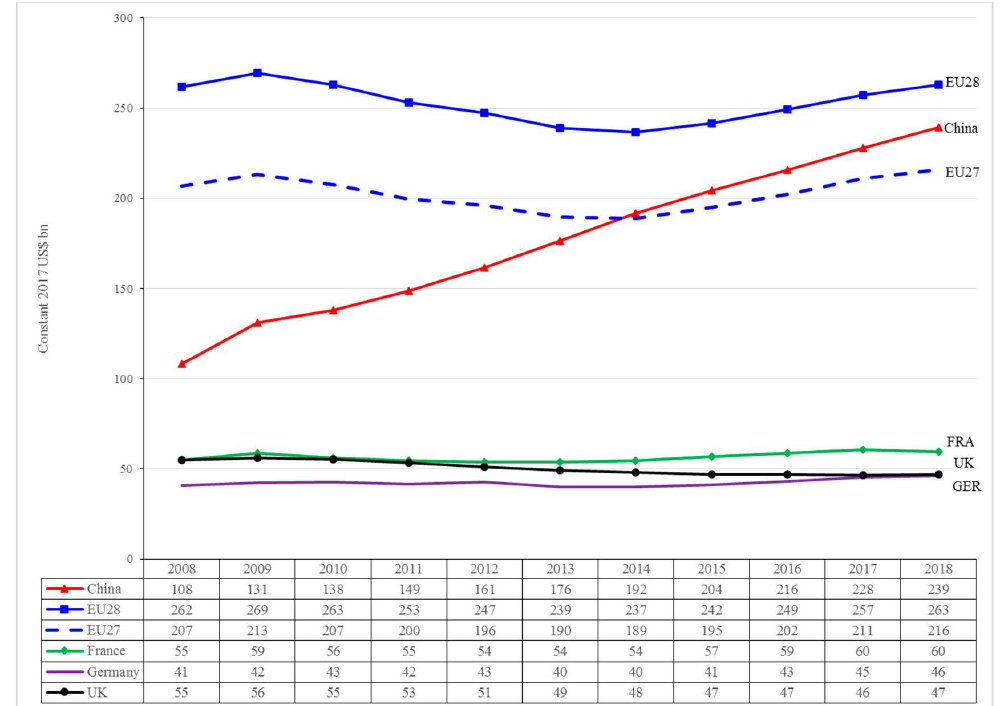
Figure 12 Defence expenditure (constant 2017 US$ [billions]), 2008–18. Source: Stockholm International Peace Research Institute, ‘Military Expenditure Database’ (2019) <https://www.sipri.org/databases/milex> accessed